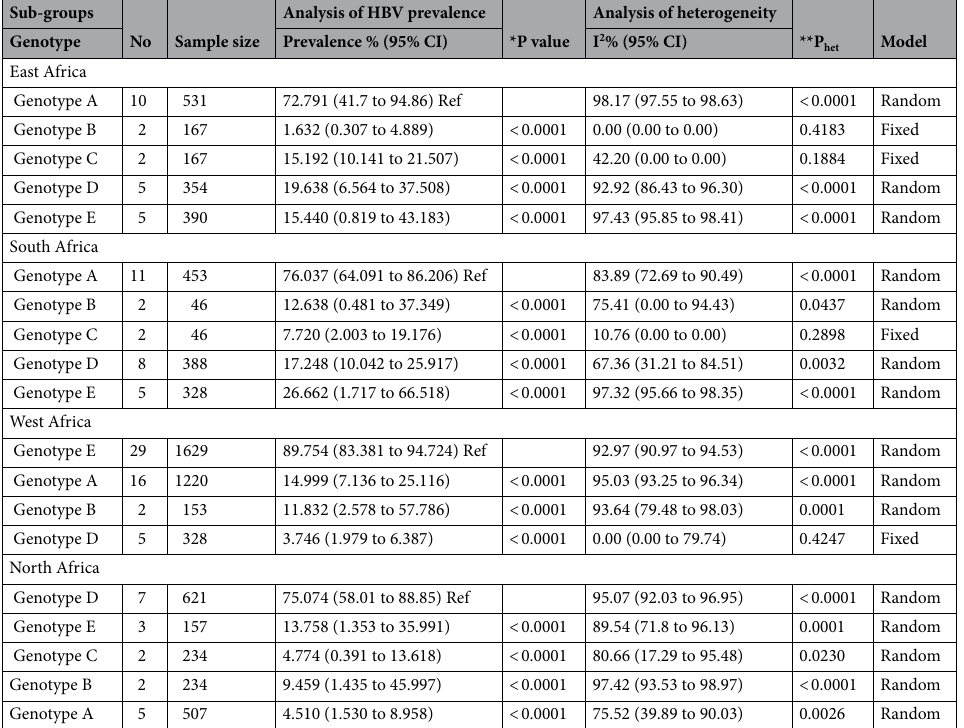
Table 2. Meta-analysis of the regional prevalence of the hepatitis B virus genotypes. *P value of genotype prevalence with respect to the reference genotype < 0.05 statistically significant. **P het < 0.1, the random-effects model was used for heterogeneity analysis.